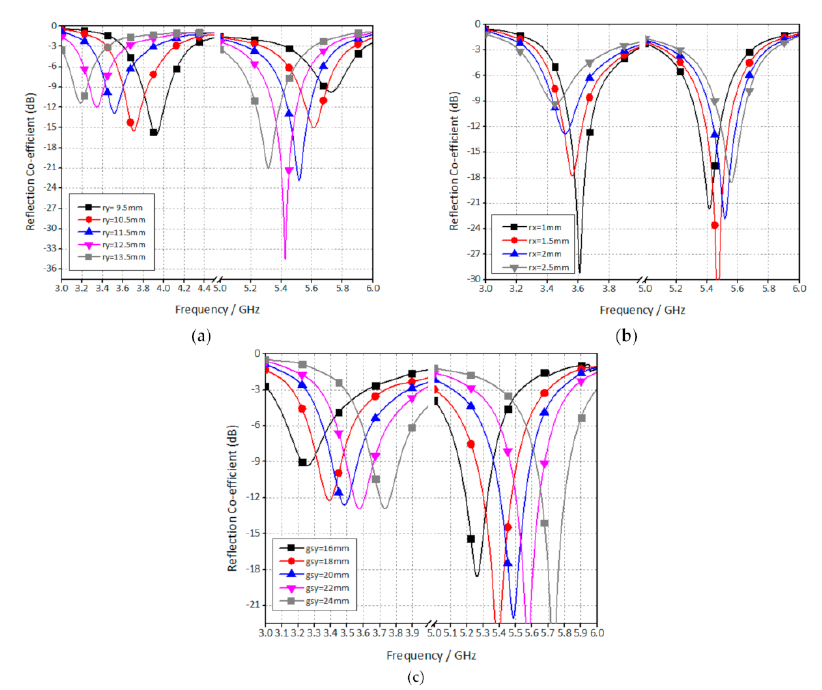
Figure 4. Parametric Analysis of proposed eight port MIMO system. ( a ) ry ( b ) rx ( c ) gsy.